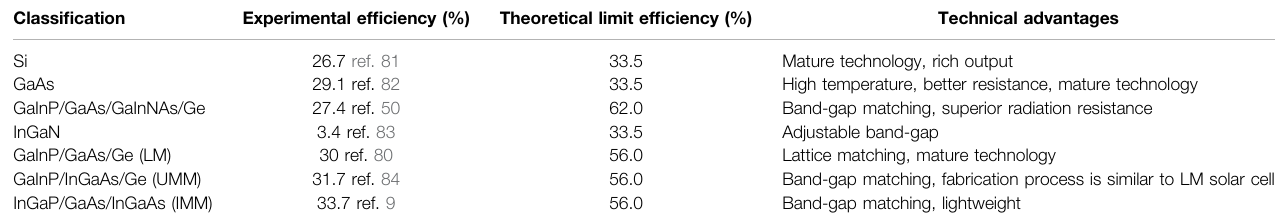
TABLE 2 | Comparison of the conversion ef fi ciency of various types of solar cells have been reported. Classi fi cation